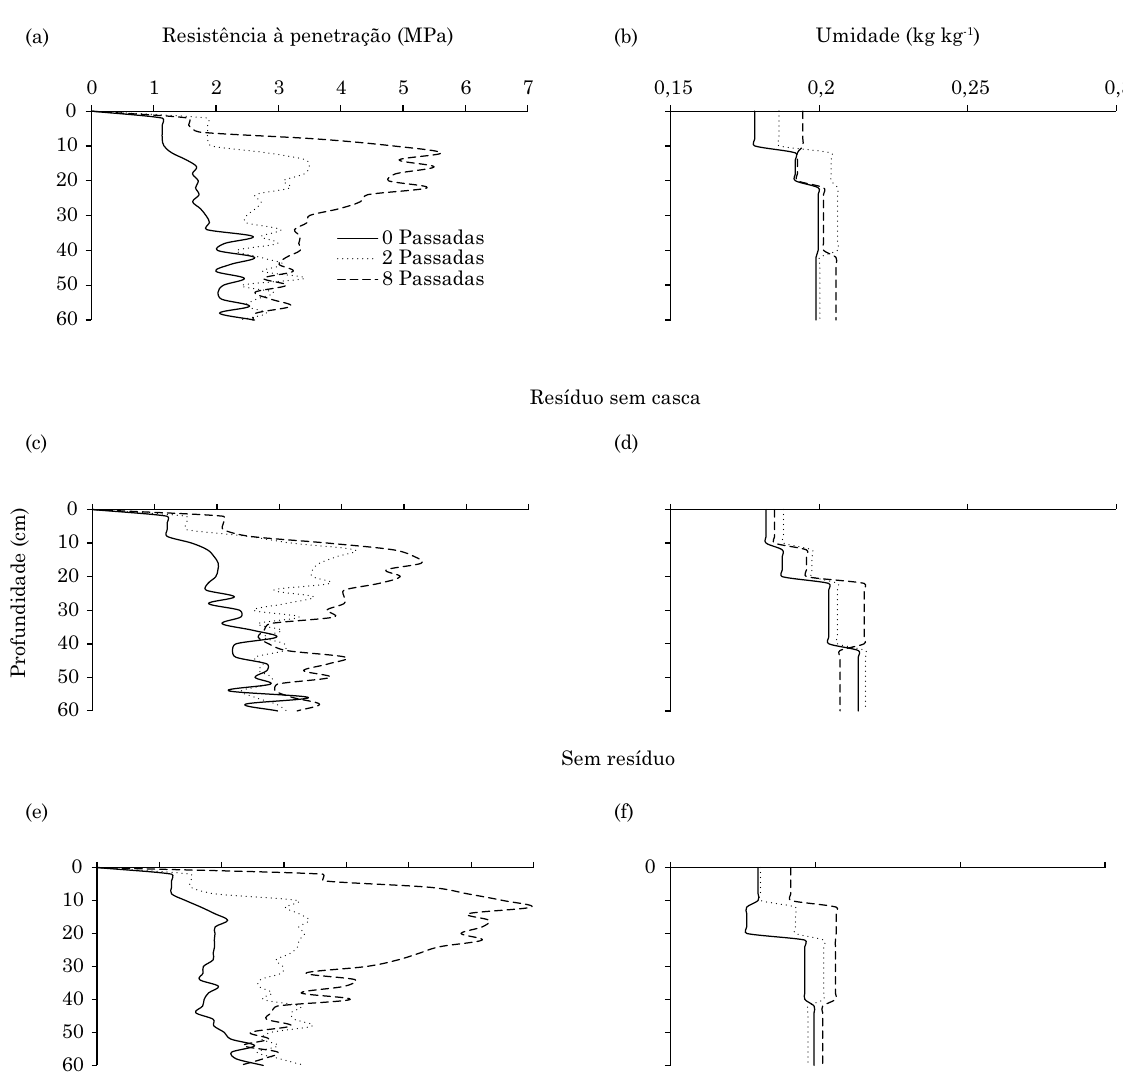
Figura 3. resistência à penetração (a, b, c) e umidade do solo (d, e, f), de acordo com o número de passadas do forwarder sobre resíduo da colheita do eucalipto sem casca (sc); resíduo com casca (cc); e solo sem resíduo (sr) de um latossolo vermelho em são João evangelista, Mg, aos 5,61 anos de idade do